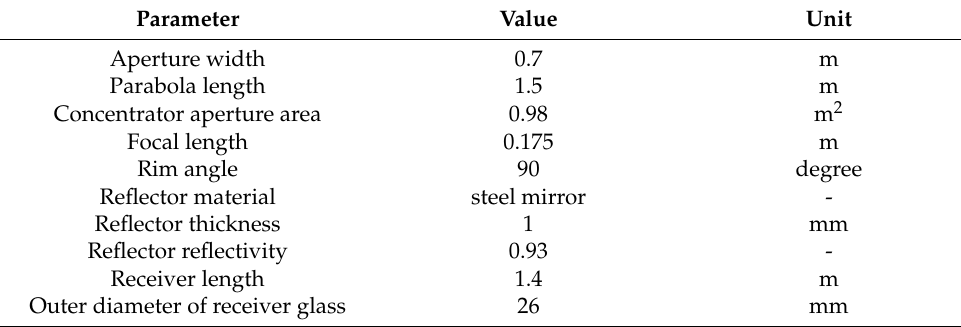
Table 1. The geometrical and optical specifications of the